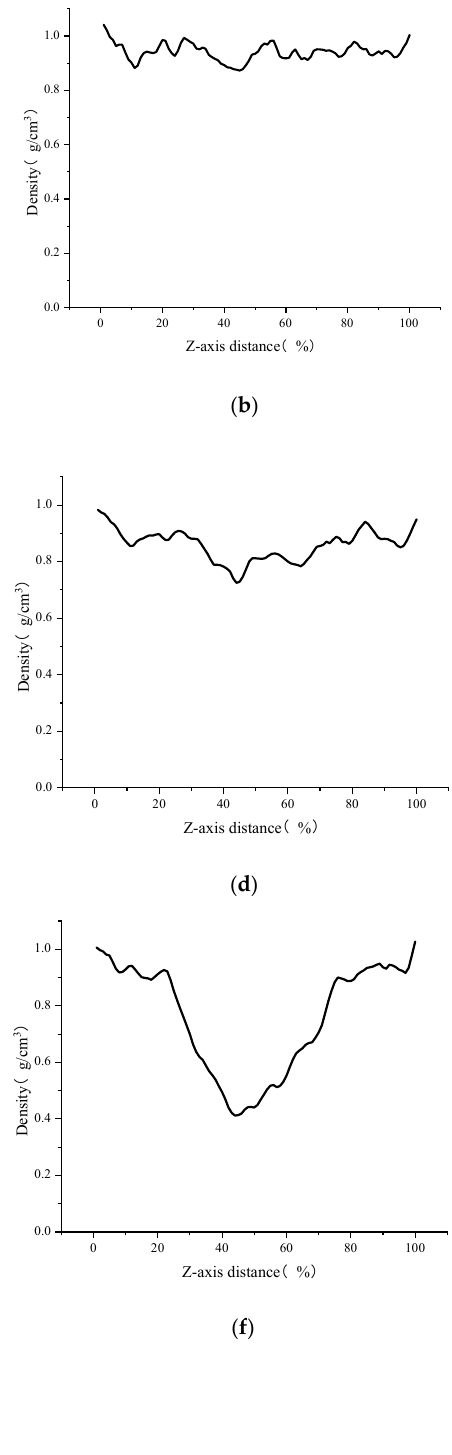
( h ) 60% strain Figure 7. Distribution function of density on the z-axis under different strain conditions. ( a ) 0% strain; ( b ) 5% strain; ( c ) 10% strain; ( d ) 15% strain; ( e ) 20% strain; ( f ) 30% strain; ( g ) 45% strain; ( h ) 60% strain. 0 ( b ) Figure 8. ( a ) Total volume versus asphalt volume change during stretching; ( b ) volume change of each part during 0–20% strain stage.